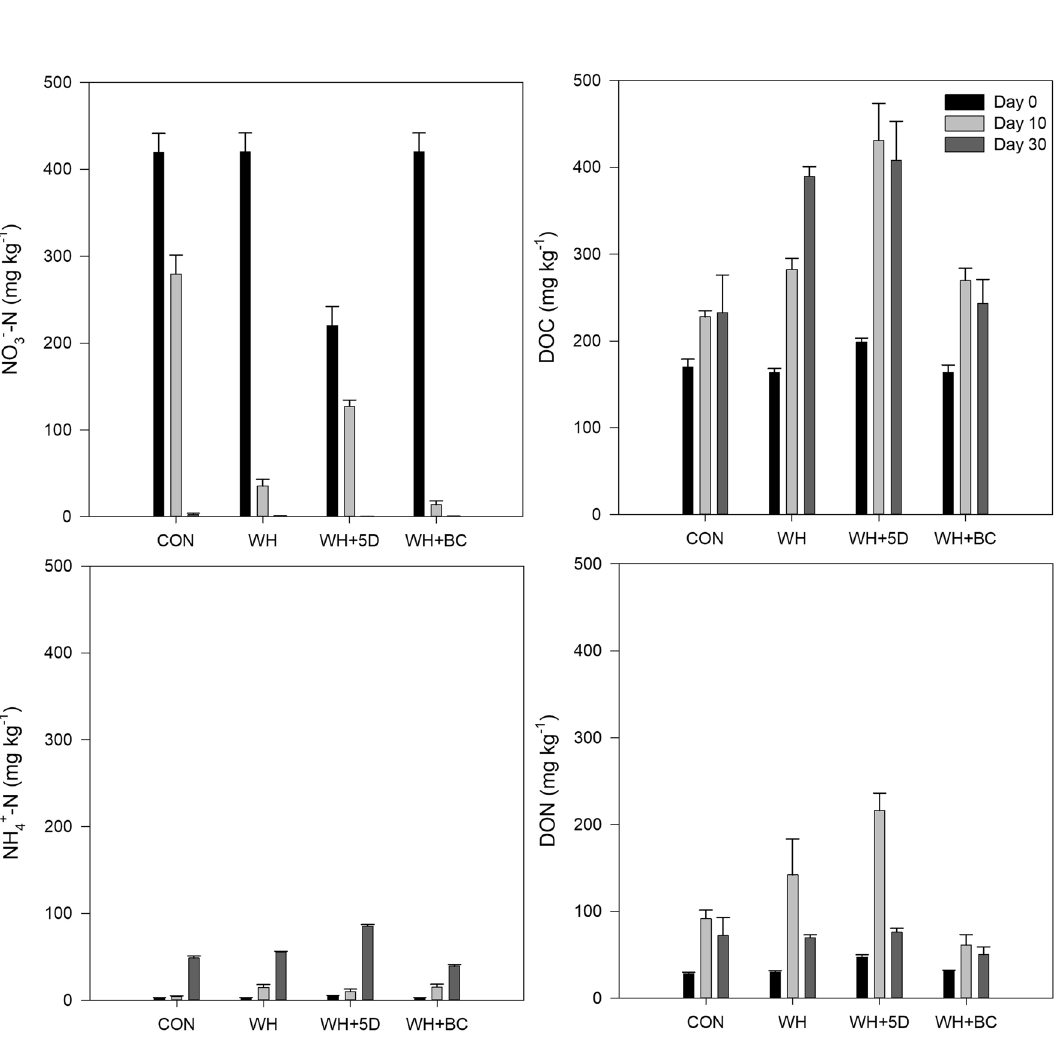
Figure 2. Nitrate, ammonium, DOC and DON contents in soil during the BSD treatment period. CON: soil without any amendments; WH: soil amended with wheat straw; WH + 5D: soil amended with wheat straw 5 days before the BSD treatment; WH + BC: soil amended with wheat straw and